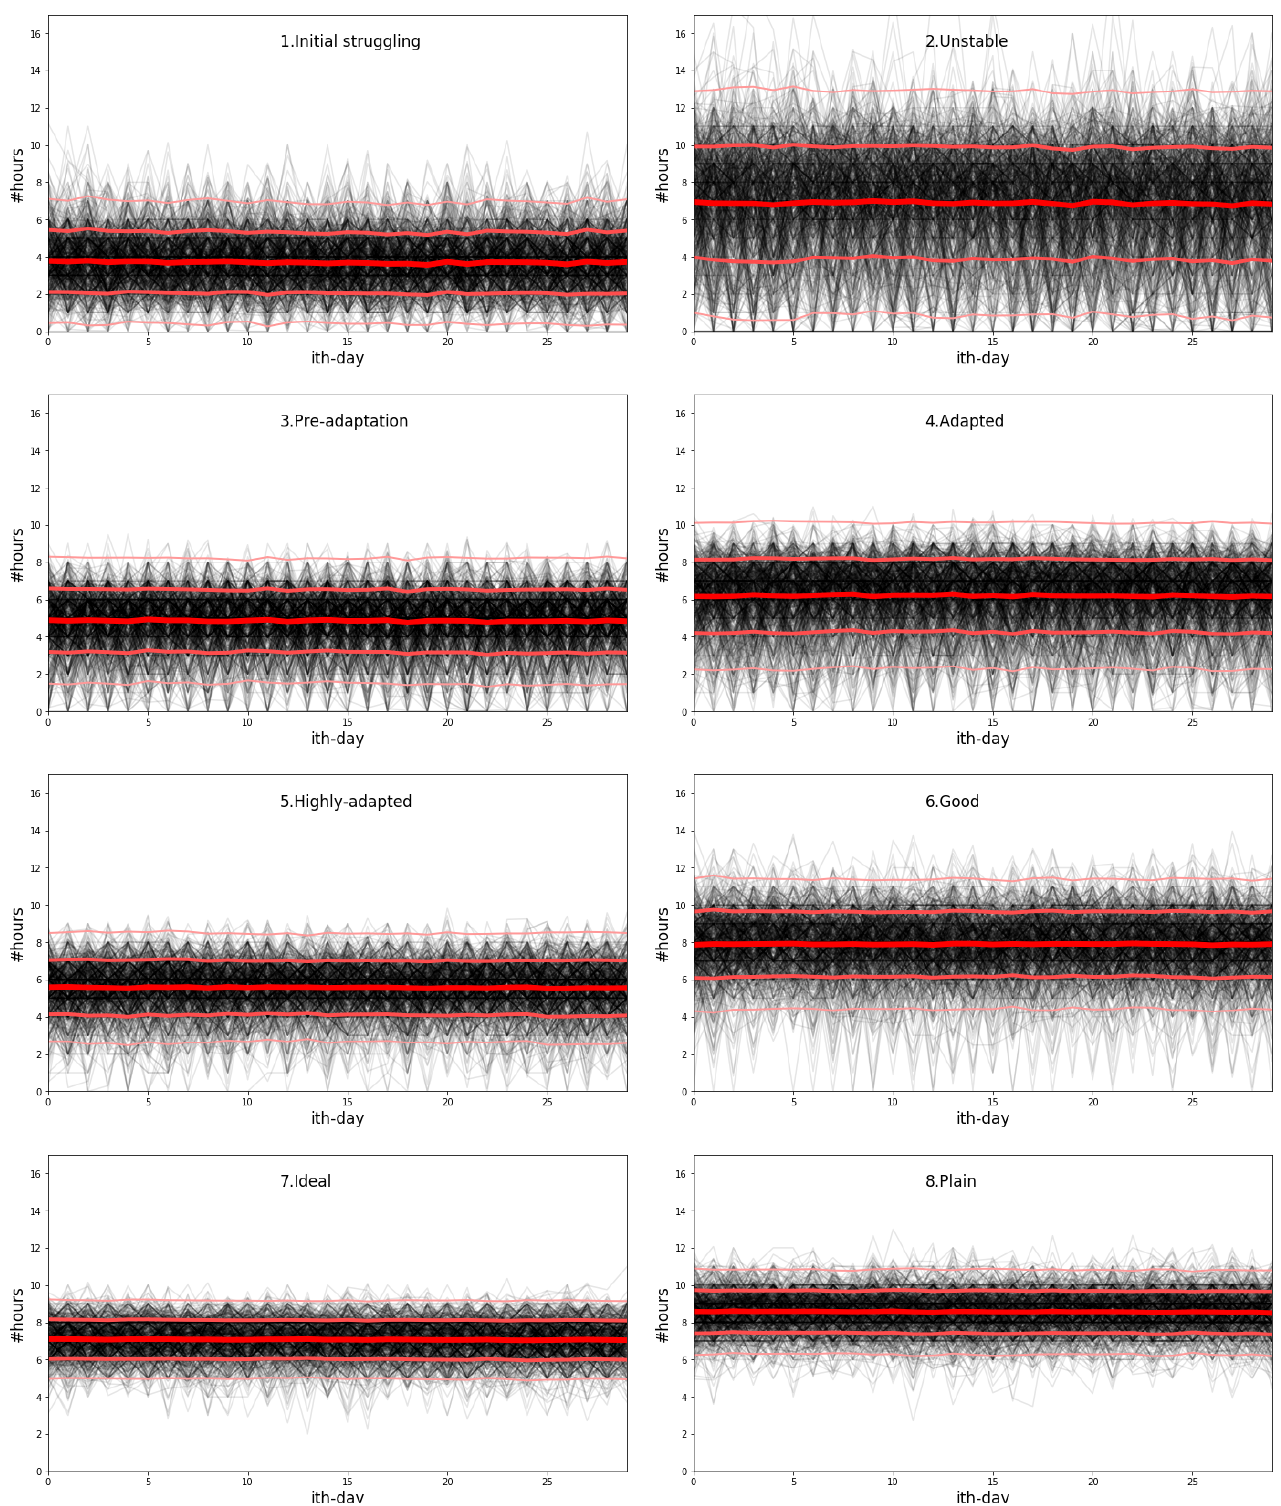
Figure 7. Time series plot of the eight components that characterize the CPAP use 30-days snippets extracted from the CPAP use dataset. Each plot presents the mean (thickest red line), the variance, and two times the variance lines. Notice that we present the average because it is a parameter to the Gaussian distribution; we do not depend on this computation to characterize the time